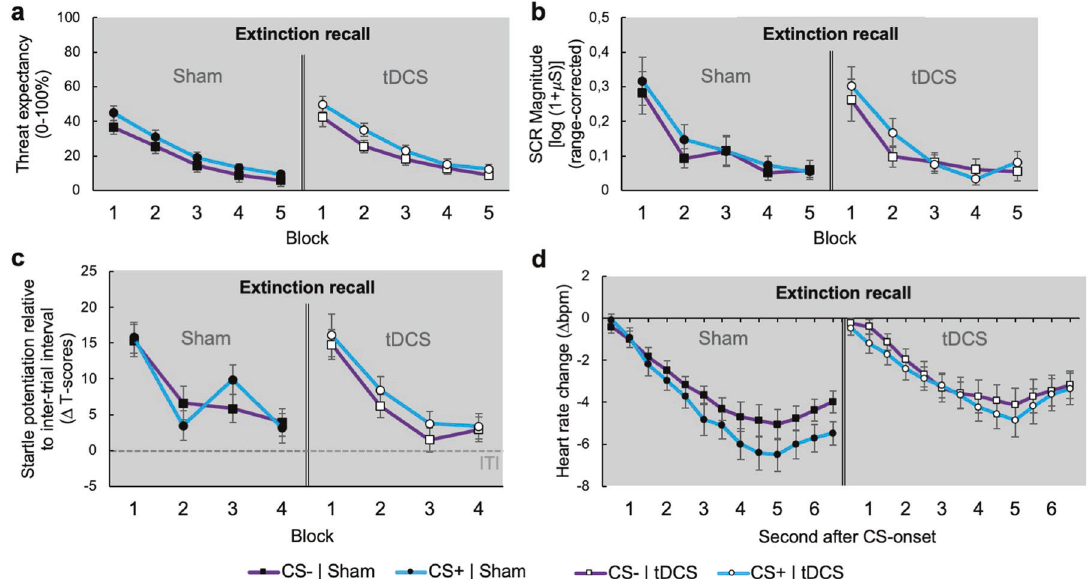
Fig. 4 Day 2: Transcranial direct current stimulation targeting the vmPFC does not impact on initial extinction recall. Overall mean US- expectancy ratings ( a ), range-corrected fi rst interval skin conductance responses ( b ), standardized (T-transformed) startle potentiation relative to inter-trial interval ( c ) and heart rate change ( d ) during the CS + (blue lines) vs. the CS − (purple lines) during the extinction recall for the sham (left panels) and tDCS condition (right panels). US-expectancy, skin conductance and startle potentiation are averaged across blocks of two trials, while heart rate change is averaged across all trials of the extinction recall. Error bars represent the standard error of the